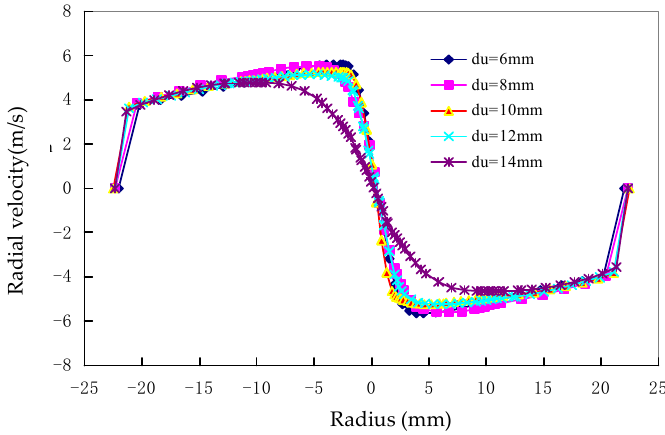
Figure 7. Radial velocity profiles at several underflow pipe diameters.